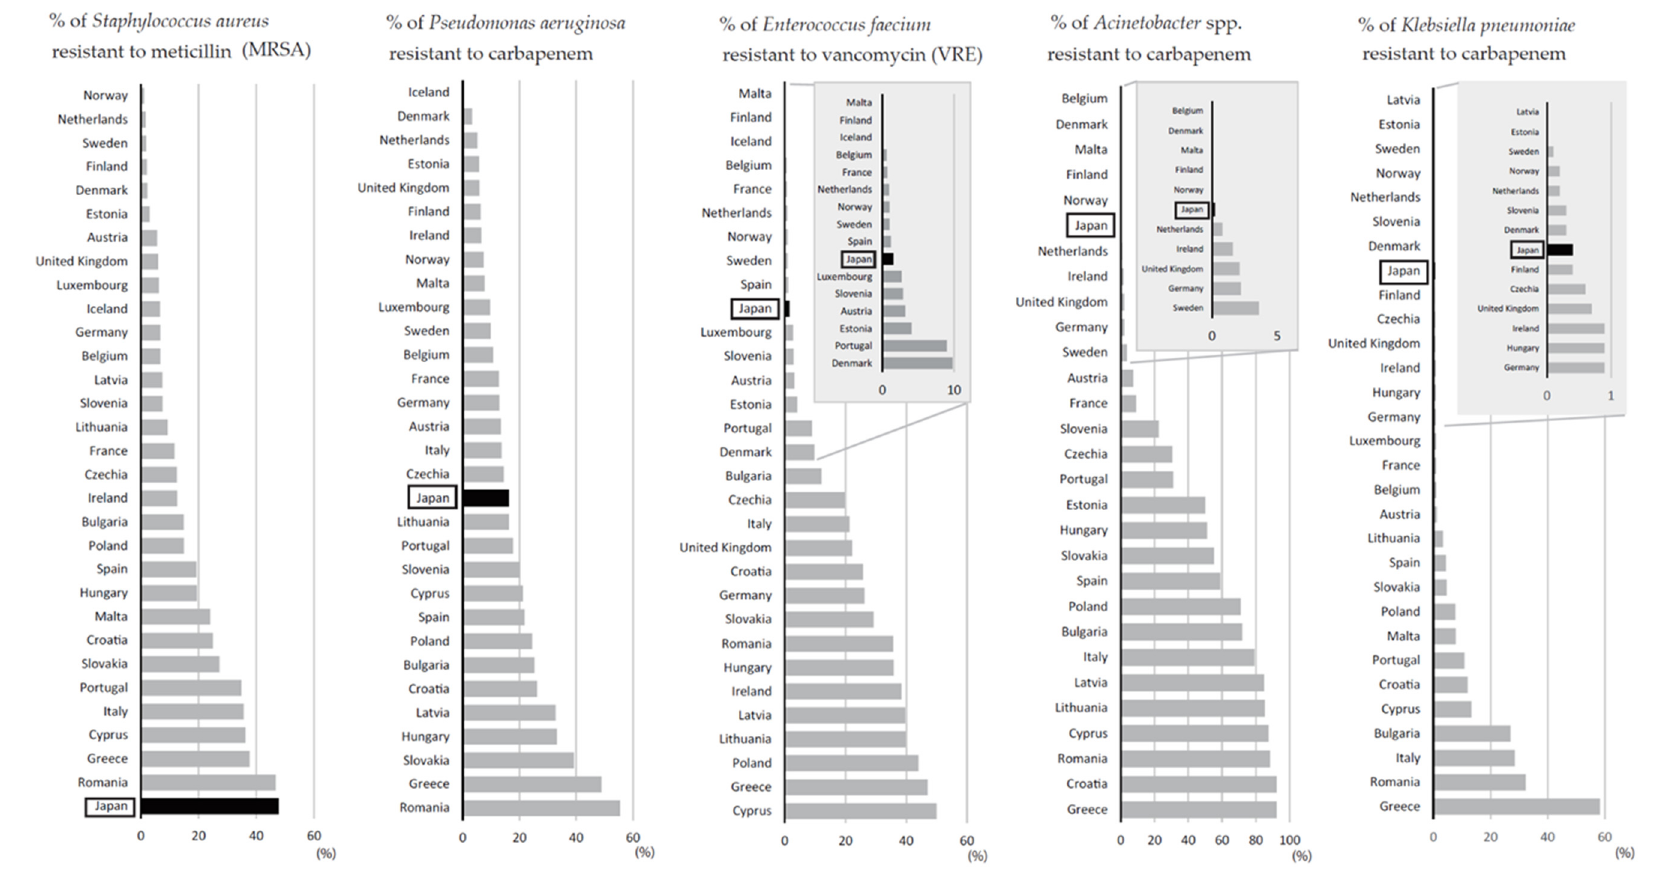
Figure 9. Comparison of resistance rates between Japan (2019 JANIS-CL annual report) and European countries for five bacterial species in 2019 [29]. The black bars indicate Japan (enclosed in rectangles), while the gray bars indicate European countries. Countries with very low resistance rates compare to those with the highest countries are magnified by a small insert with a grey background. The graphs are arranged in order of the epidemic/spread of each AMR bacteria in Japan: MRSA, 1980s to 2000s; MDRP (carbapenem-resistant P. aeruginosa ), 1990s to mid-2000s; VRE (vancomycin-resistant E. faecium ), 2000s; MDRA (carbapenem-resistant Acinetobacter spp.), late 2000s to early 2010s; CRE (carbapenem-resistant K. pneumoniae ), 2010s.